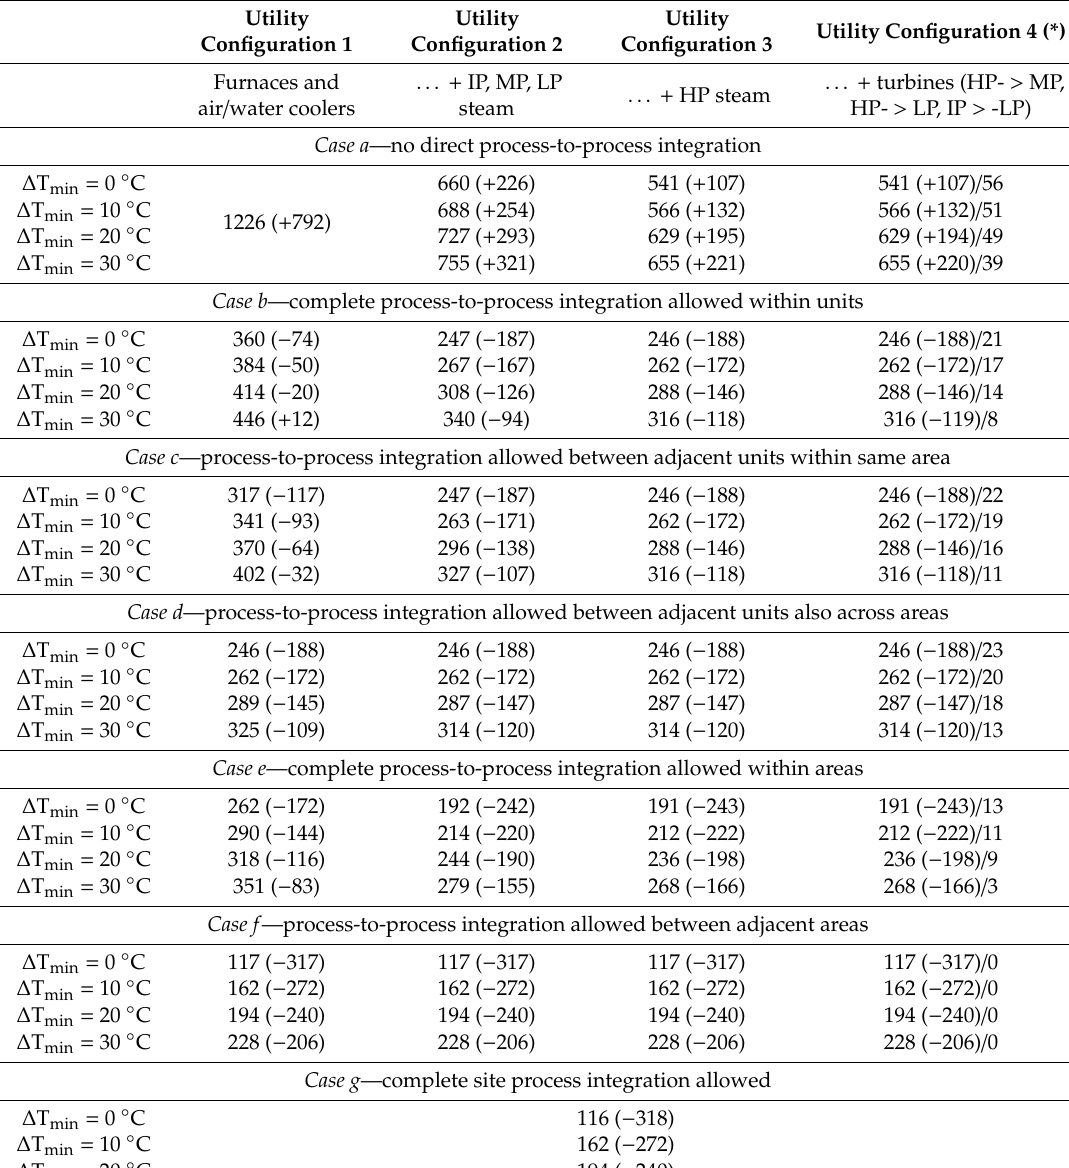
Table 1. Calculated minimum hot utility (MW) for the di ff erent process-to-process and process-to-utility aggregation levels considered and di ff erence compared to the current hot utility demand (434 MW) within brackets. (* For utility configuration 4 cogeneration targets (MW) are also shown: hot utility /